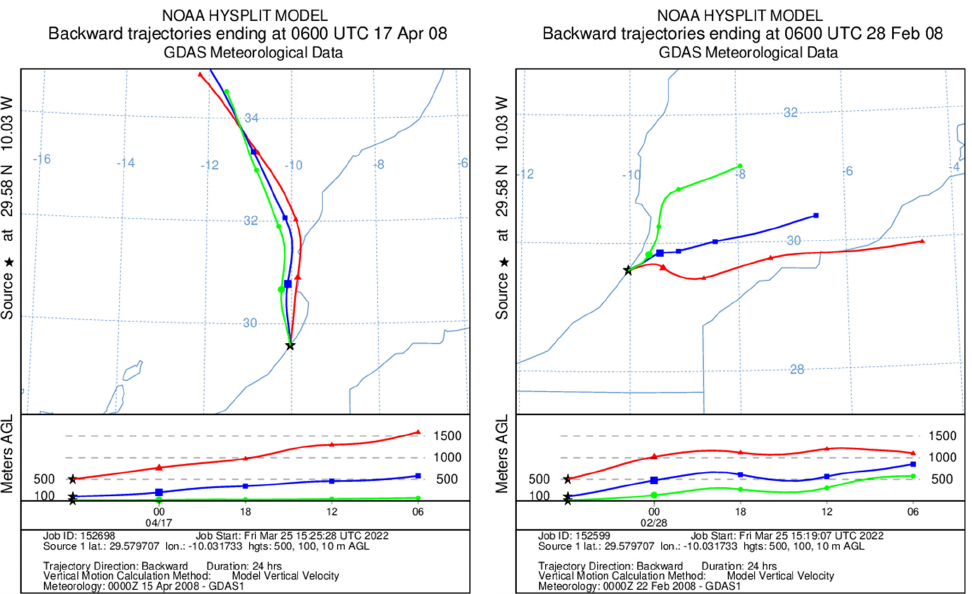
Figure 15. Some typical 24 h low elevation air mass backward trajectories for Mirleft at 6:00, corre- sponding to dew events. Colored lines represent the path of air masses starting at 500 m (red triangles and lines), 100 m (blue squares and lines), 10 m (green circles and lines) above the collection site. Data are taken every 6 h, corresponding to the points on the trajectories. From [68].